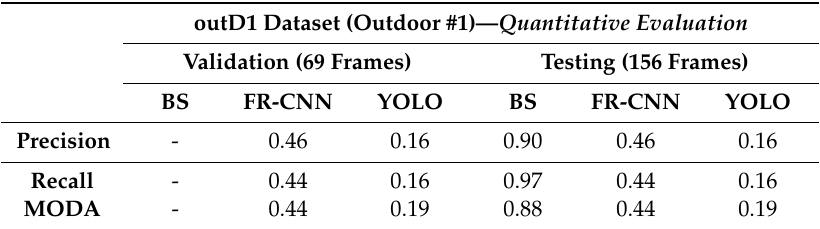
Table 2. Quantitative results from the outdoor dataset outD1.